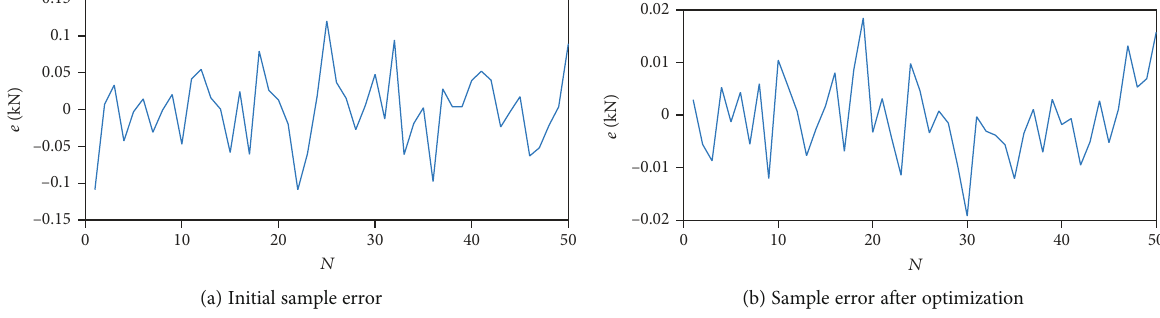
Figure 7: Changing trend of sample error in the optimization process.